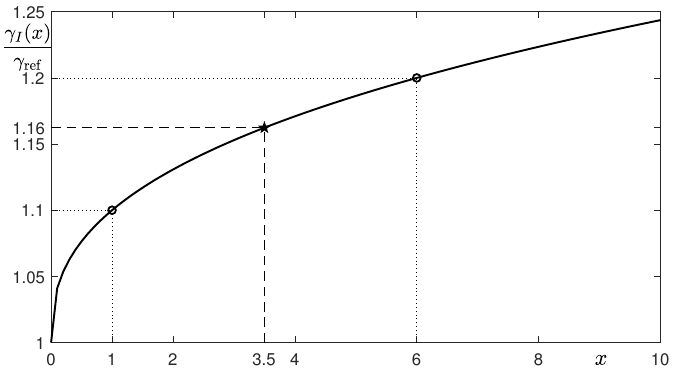
Figure 7. Plot of the fitting function for a power cost function, γ I ( x ) / γ ref = 1 + exp ( A ) x b